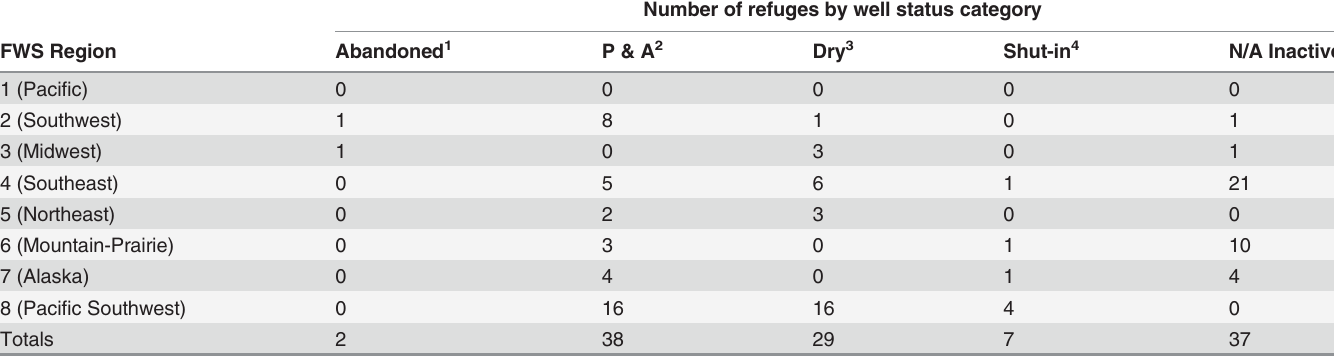
Table 2. Number of NWRS units with non-producing oil and gas wells.